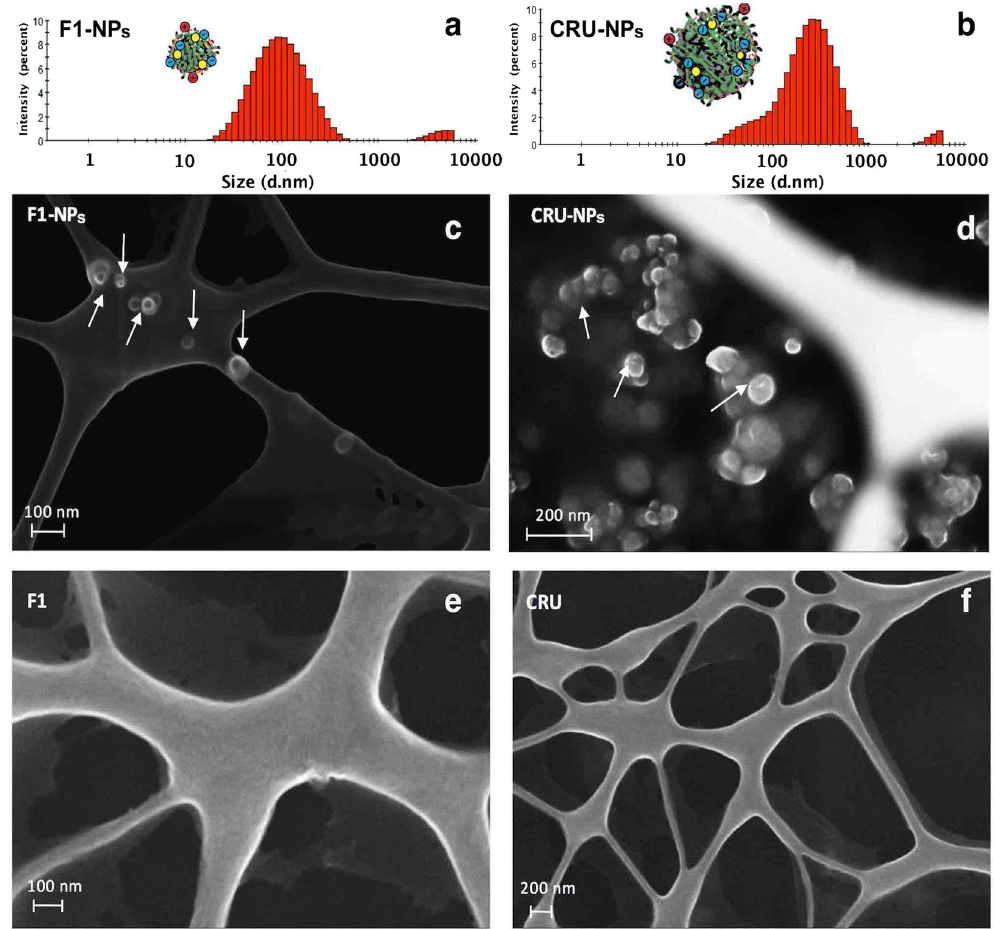
Figure 3. Intensity-based size distribution histograms of ( a ) F1-NPs (nanoparticles formed from cruciferin peptide fraction < 10 kDa) and ( b ) CRU-NPs (nanoparticles formed from cruciferin peptides) from the dynamic light scattering and SEM micrographs for representative ( c ) F1-NPs, ( d ) CRU-NPs, ( e ) F1 (cruciferin peptide fraction < 10 kDa), and ( f ) CRU (cruciferin peptides) on copper